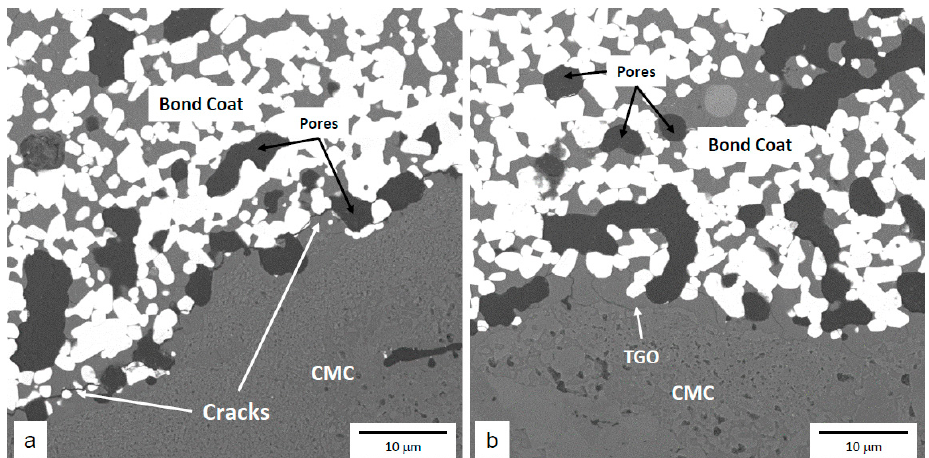
Figure 11. Cracks along the bond coat/CMC interface shown in Figure 10c become gradually narrower towards the flatter surface ( a ) and completely disappear at and near the flat surface ( b ).